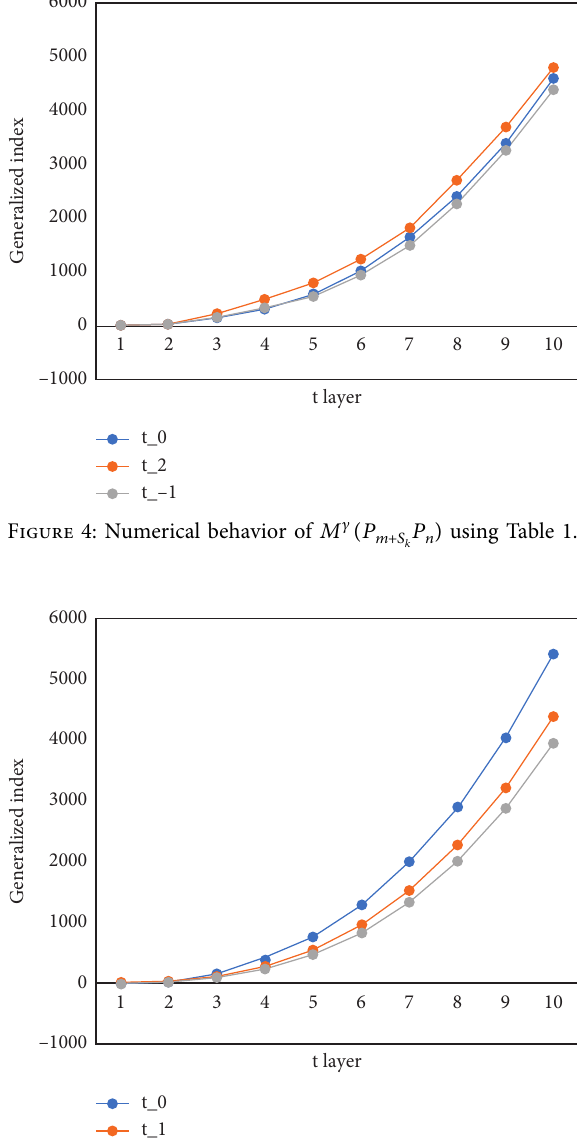
Table 1: Numerical comparison for M c ( P